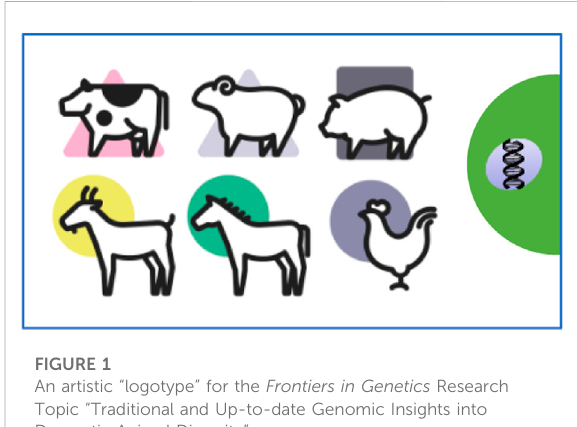
FIGURE 1 An artistic “ logotype ” for the Frontiers in Genetics Research Topic “ Traditional and Up-to-date Genomic Insights into Domestic Animal Diversity ”